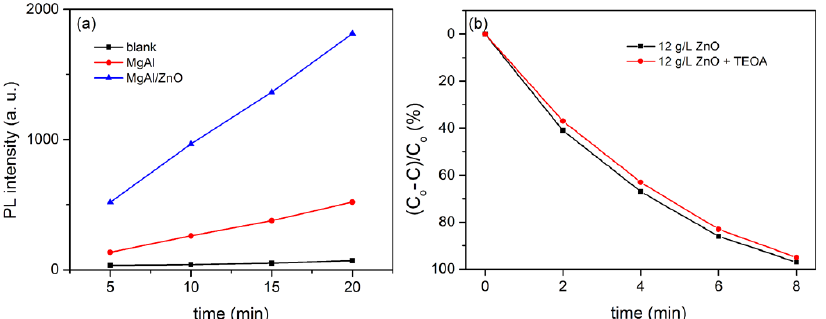
Figure 8. ( a ) PL intensity at 425 nm emission of MgAl and MgAl/ZnO coatings excited with 315 nm radiation; ( b ) the photodegradation MO on the MgAl/ZnO coating formed in aluminate electrolyte + 12 g/L ZnO in the presence of 1mM TEOA as H + hole scavenger.